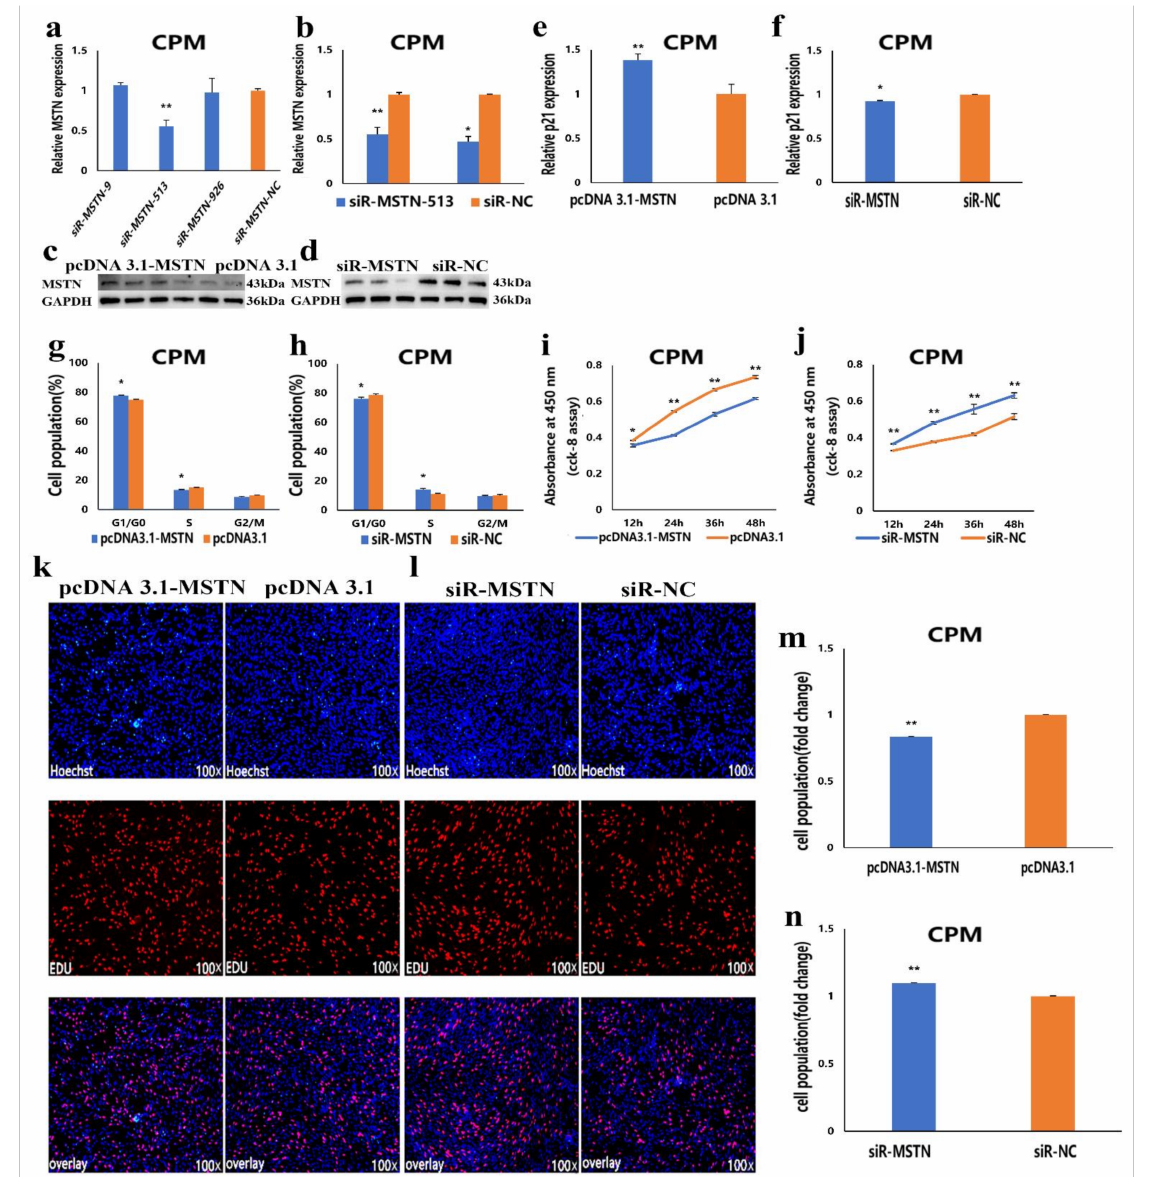
Figure 5. The facilitation of miR-27b-3p on CPMs proliferation was achieved by its target gene MSTN . ( a , b ) Screening of MSTN gene interference sequence and detection of interference efficiency. ( c , d ) The protein expression levels of MSTN in CPMs after overexpression and interference. ( e , f ) The relative mRNA expression of p21 after transfection with pcDNA 3.1-MSTN and pcDNA 3.1 in CPMs. ( g , h ) Cell-cycle analysis of CPMs 48 h after transfection with pcDNA 3.1-MSTN and pcDNA 3.1 in CPMs, using propidium iodide staining for DNA content. ( i , j ) Cell growth was measured following the transfection of pcDNA 3.1-MSTN and pcDNA 3.1 in CPMs. ( k , l ) The proliferation of CPMs following transfection with pcDNA 3.1-MSTN and pcDNA 3.1 was assessed by EdU incorporation. Microscopic images were obtained by a fluorescence inverted microscope (dmi8, Leica, Germany). ( m , n ) Proliferation rates of CPMs following transfection with pcDNA 3.1-MSTN and pcDNA 3.1. In all graphs, the results are shown as mean ± SEM (standard error of the mean) ( n = 3). Statistical significance of differences between means was assessed, using the unpaired Student’s t -test (* p < 0.05; ** p < 0.01) vs. NC (negative